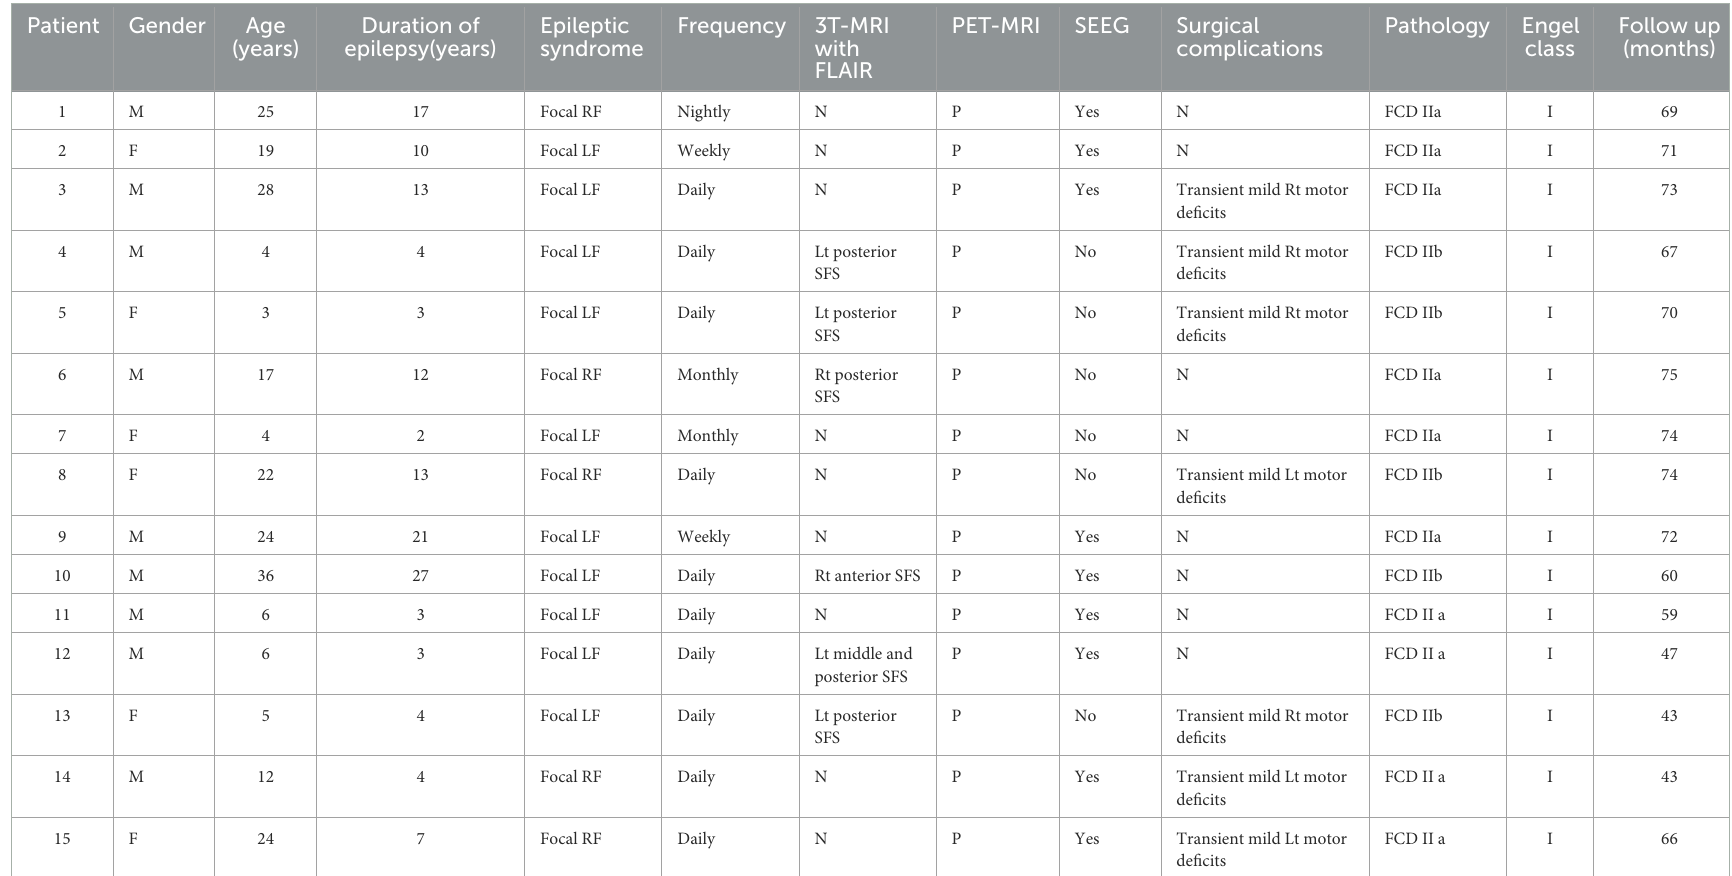
TABLE 1 Demographic features and clinical manifestations of the PS group.